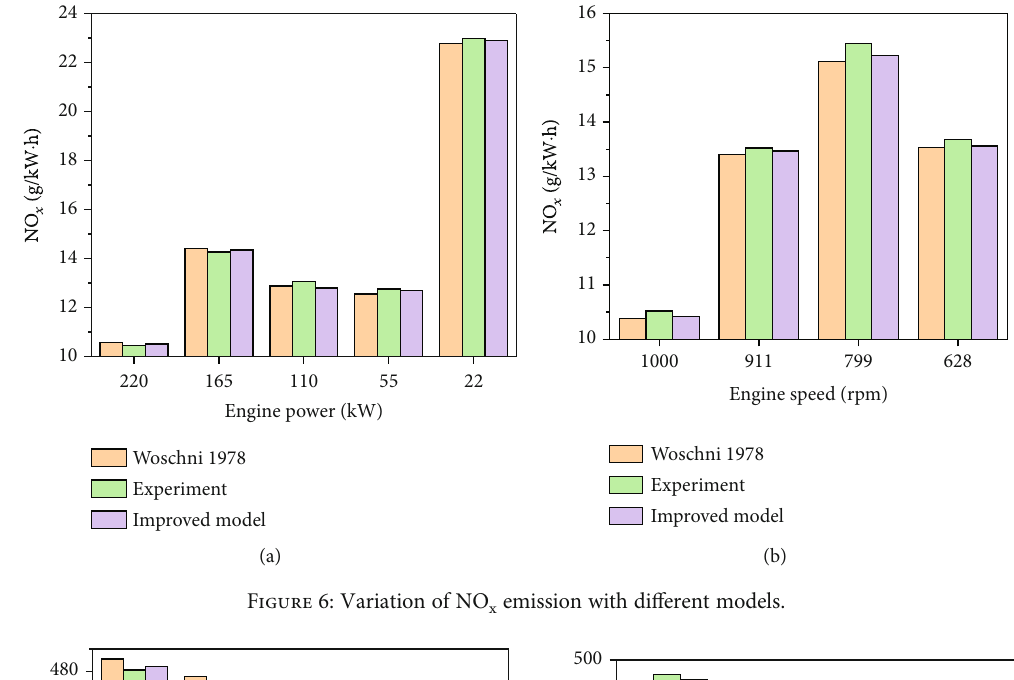
emission with di ff erent models. x